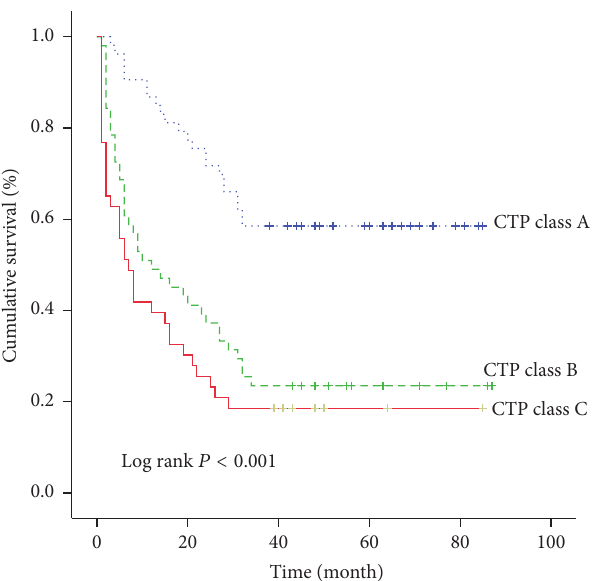
Figure 4: The cumulative survival rate of patients in different CTP class.